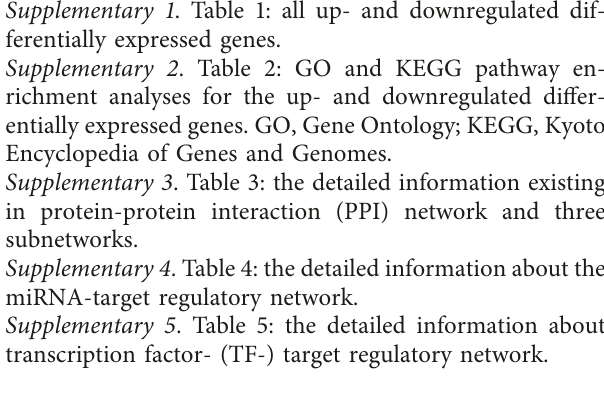
Supplementary 1 . Table 1: all up- and downregulated dif- ferentially expressed genes. Supplementary 2 . Table 2: GO and KEGG pathway en- richment analyses for the up- and downregulated differ- entially expressed genes. GO, Gene Ontology; KEGG, Kyoto Encyclopedia of Genes and Genomes. Supplementary 3 . Table 3: the detailed information existing in protein-protein interaction (PPI) network and three subnetworks. Supplementary 4 . Table 4: the detailed information about the miRNA-target regulatory network. Supplementary 5 . Table 5: the detailed information about transcription factor- (TF-) target regulatory